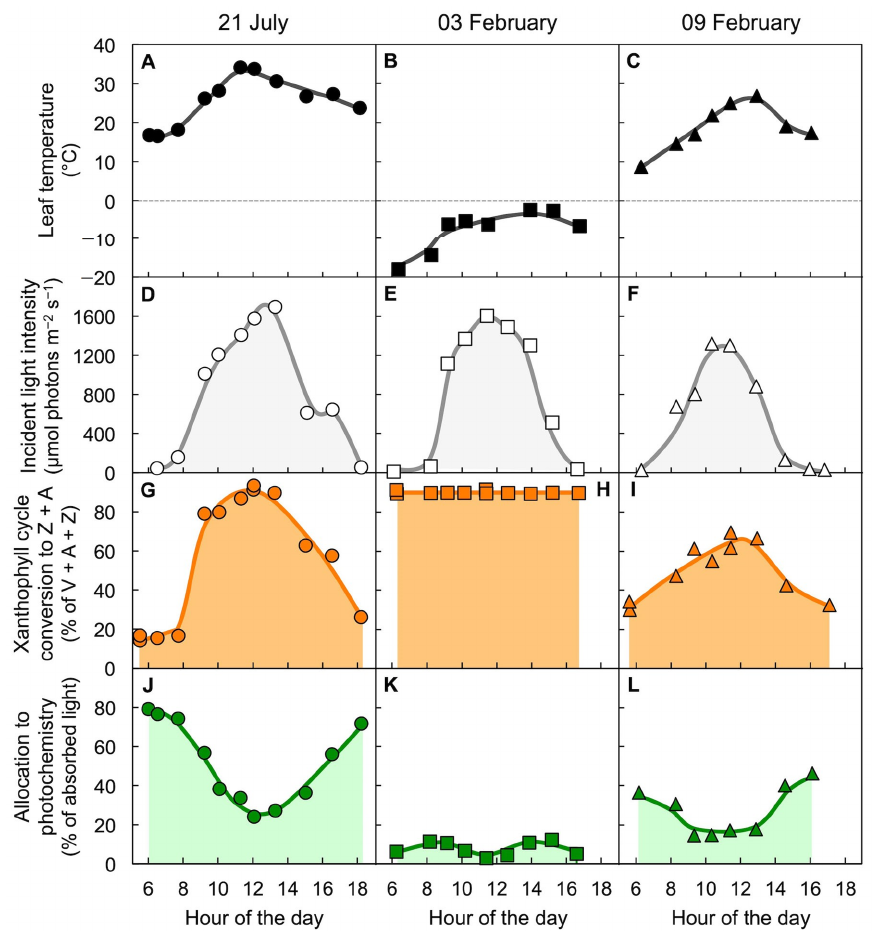
Figure 15. Diurnal characterization of ( A , B , C ) leaf temperature, ( D , E , F ) light incident on the upper leaf surface, ( G , H , I ) percent of the xanthophyll cycle present as zeaxanthin and antheraxanthin (Z + A), and ( J , K , L ) percentage of absorbed photons allocated to photochemistry (quantified from chlorophyll fluorescence as photosystem II efficiency) in leaves of the woody evergreen Euonymus kiautschovicus on a warmdayduringsummer( A , D , G , H ;circles), onacolddayinwinter( B , E , H , I ;squares), andasubsequent warmer winter day ( C , F , I , L ; triangles). V = violaxanthin. Data are from Verhoeven et al.